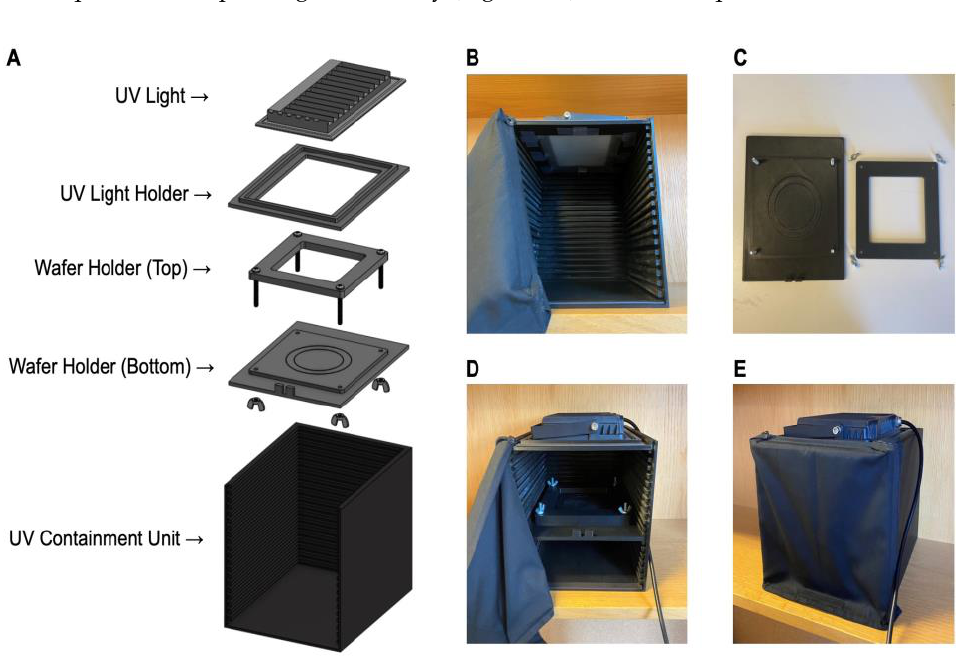
Figure 1. Schematic of the DUV Light System. ( A ) 3D exploded view of the DUV Light System. ( B ) Photo of the inside of the UV light system, showcasing the shelving system and the light diffusing film underneath the UV lamp. ( C ) Photo of the individual mask holder components. ( D ) Photo of the completed assembly. ( E ) Photo of the assembly with the curtain closed, as one would set up for use of the